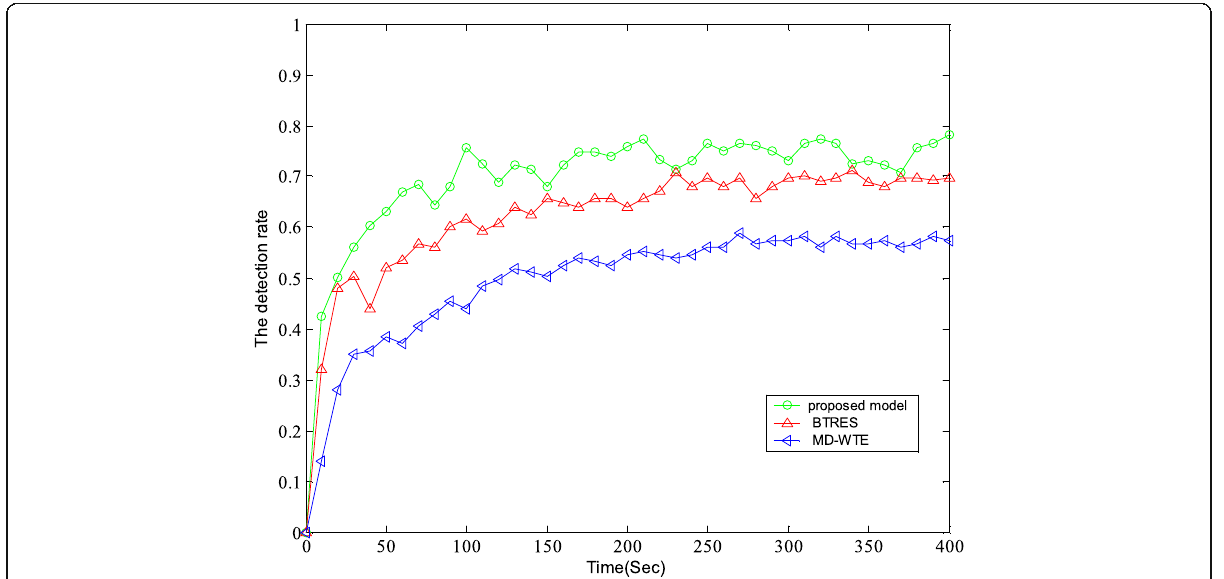
Fig. 4 The detection rate with time as malicious node ’ s proportion is